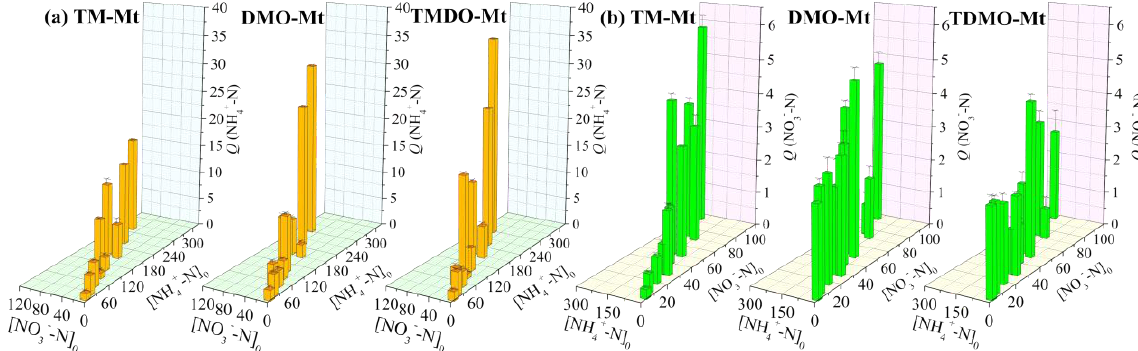
Figure 7. Influence of initial concentration on the adsorption of ( a ) NH 4+ − N and ( b ) NO 3 − − N using the grafted Mt.